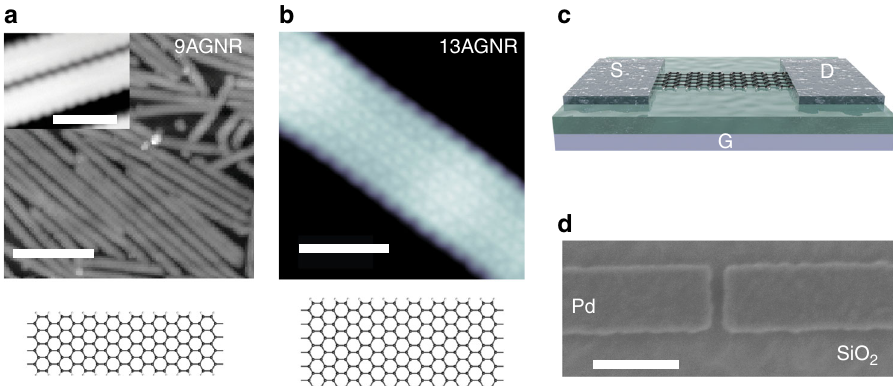
Fig. 1 High-resolution STM GNR characterization and FET structure. a STM image of synthesized 9AGNR on Au with a scale bar of 10 nm ( V s = 1 V, I t = 0.3 nA). Inset : High-resolution STM image of 9AGNR on Au ( V s = 1 V, I t = 0.5 nA) with a scale bar of 1 nm. b High-resolution STM image of 13AGNR on Au with a scale bar of 2 nm ( V s = − 0.7 V, I t = 7 nA). c Schematic of the short channel GNRFET with a 9AGNR channel and Pd source-drain electrodes. d